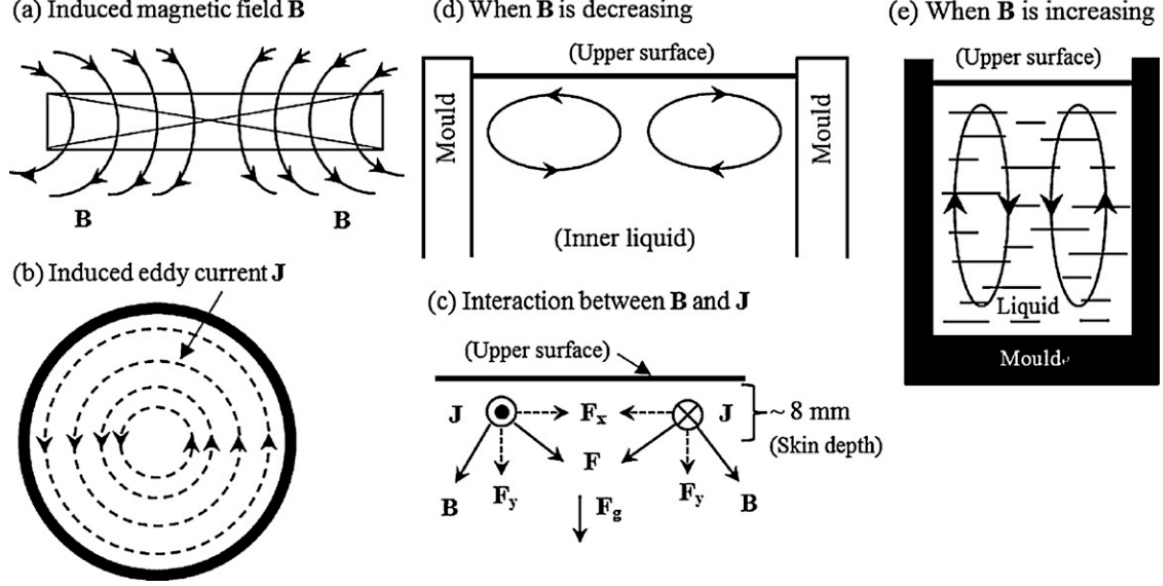
Figure 24. Illustration of fundamental principles of the PMF process: ( a ) side view of magnetic field induced by the induction coil; ( b ) top view of induced eddy current in the melt; ( c ) interaction between the magnetic field and eddy current; ( d ) a minor form of forced convection within the surface layer occurs when B is decreasing; and ( e ) a major form of forced convection is aroused when B is increasing [23]. Copyright 2012,